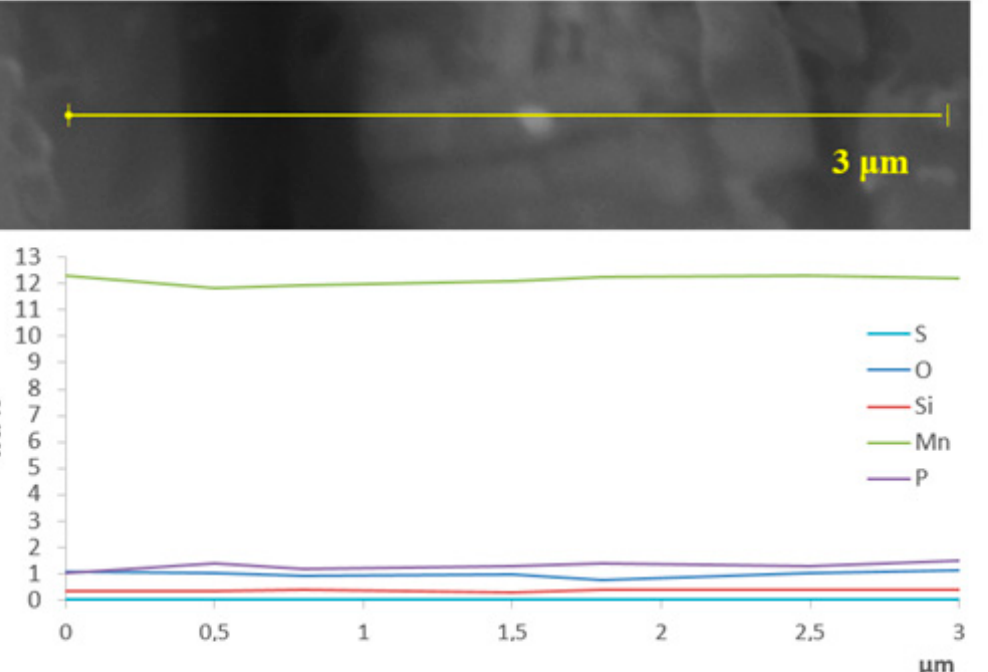
( b ) ( c ) Figure 4. TEM images of the dislocation substructure of Hadfield steel deformed by tension with ε ≤ 5%: ( a ) long dislocations; ( b ) stacking faults, ( c ) tangles of dislocations.